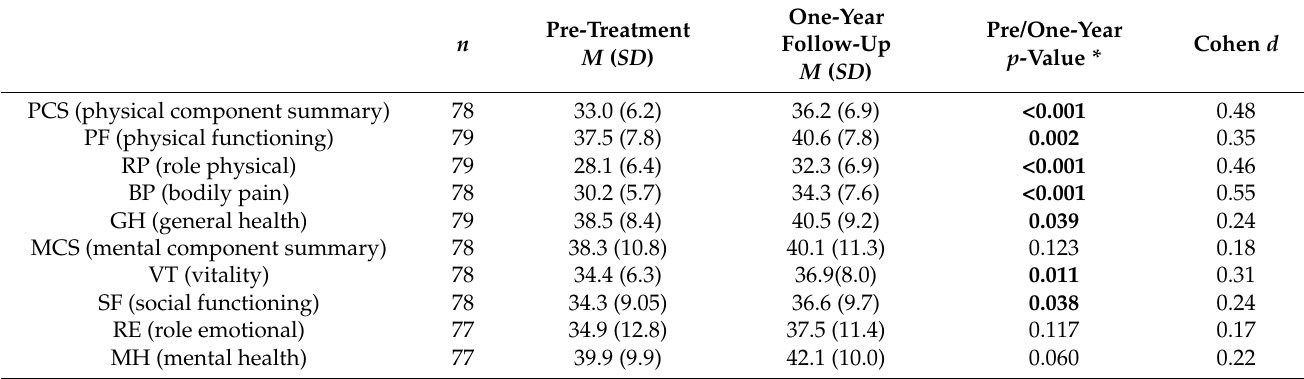
Table 4. The mean difference in HRQOL pre-treatment and at one-year follow-up ( n = 79).